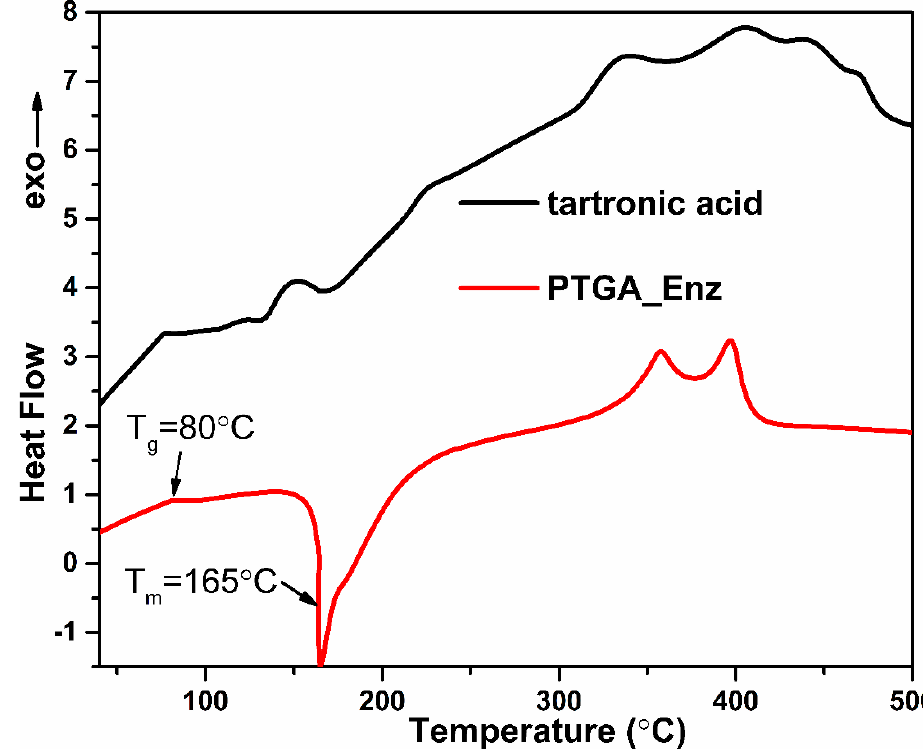
Figure 8. DTA pattern in the air of tartronic acid (black line) and PTGA_Enz (red line) at a heating rate of 10 °C min − 1 between 30 °C and 800 °C.